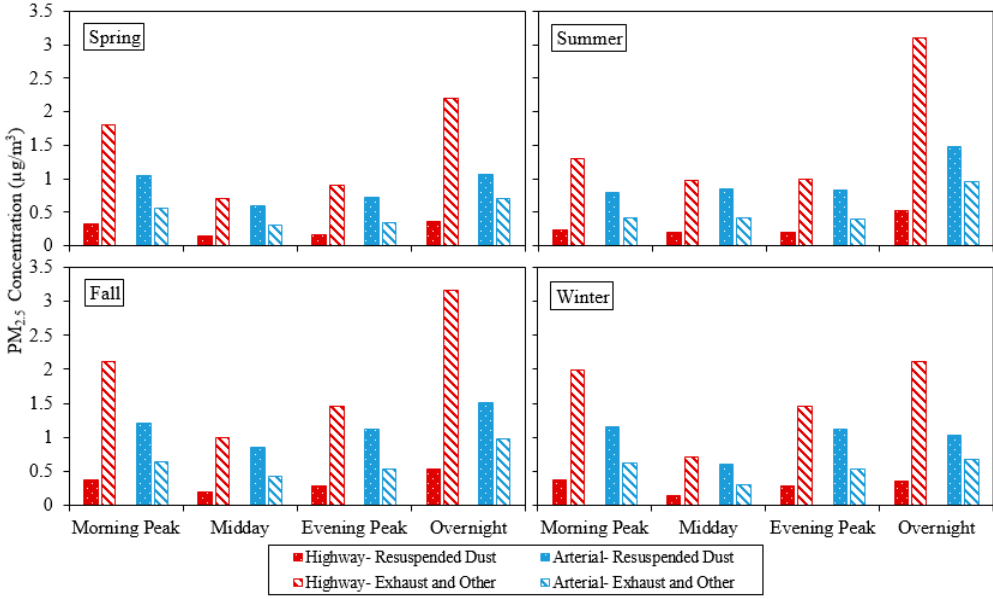
Figure 3. Predicted PM 2.5 concentrations.